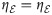
Historical reconstructions of world cumulative production W and atmospheric CO2 concentrations with projections assuming ηc = 0 and ηE=ηE (2017) = 2.4%yr−1 (circles) and corresponding stabilization concentrations from Eq 39.The halving time between predicted and committed is about 30 years. Concentration data includes flask samples from Mauna Loa [41] and Antarctic ice core data [42, 43].